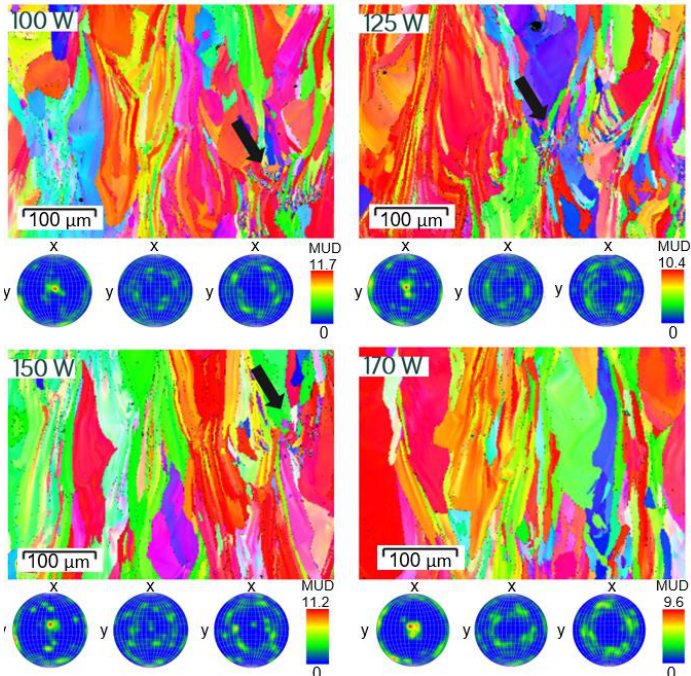
Figure 6. EBSD maps related to all power conditions.